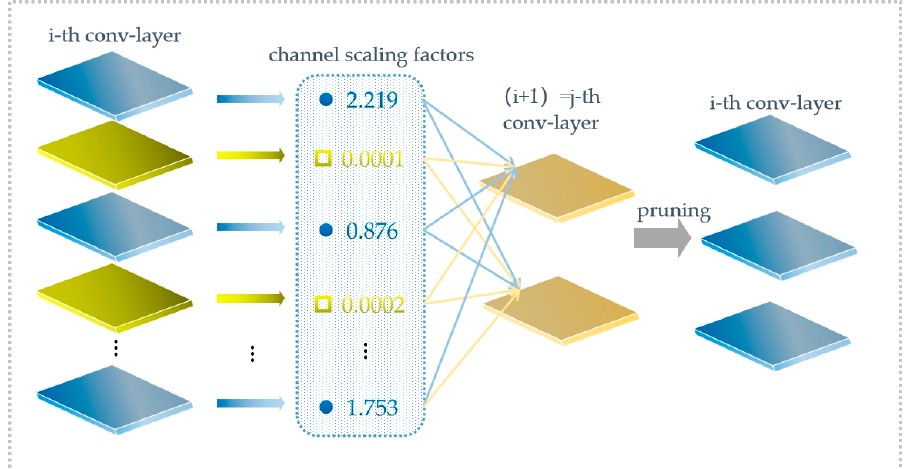
Figure 5. Process of network pruning.